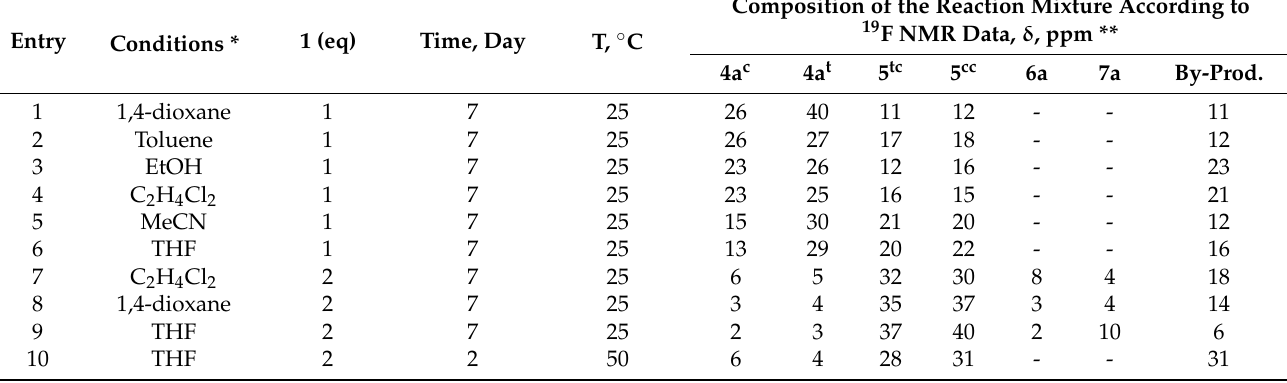
Table 1. Optimization of the reaction conditions for ethyl trifluoropyruvate 1 , acetone 2a , and aminoethanol 3a